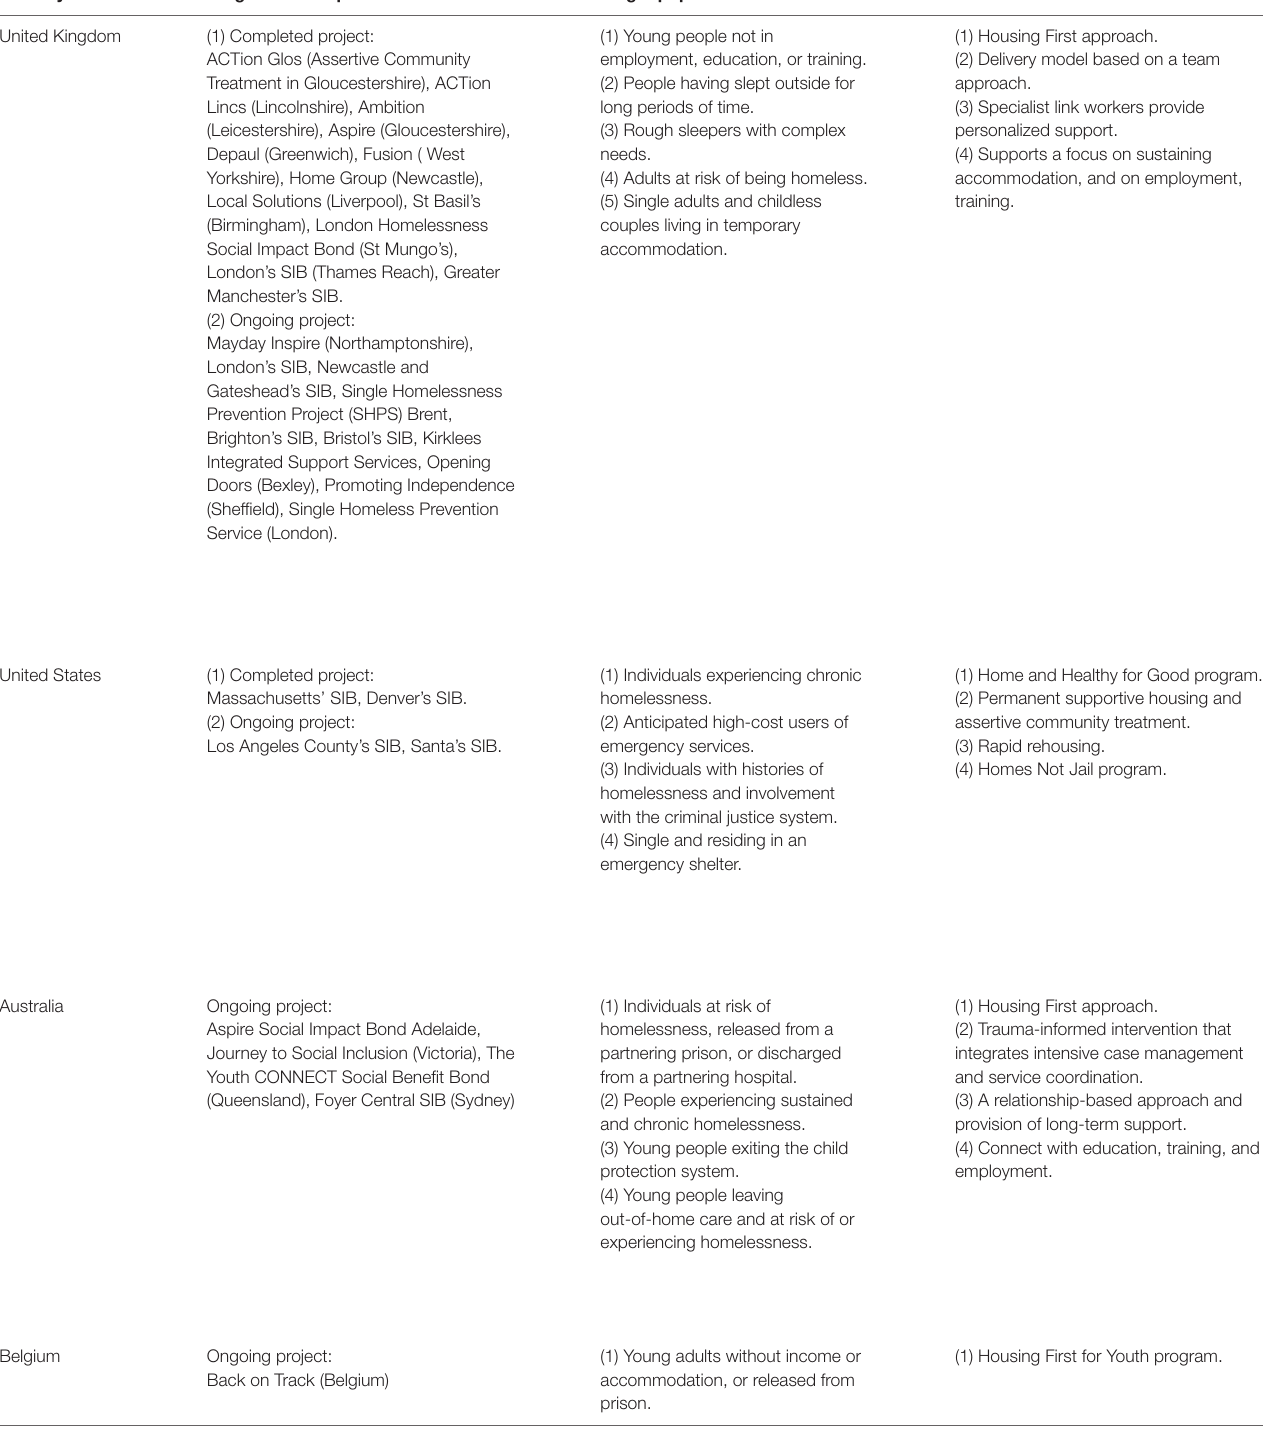
TABLE 2 | Target population and interventions of all SIBs for homelessness to date. Country Stage of development Target